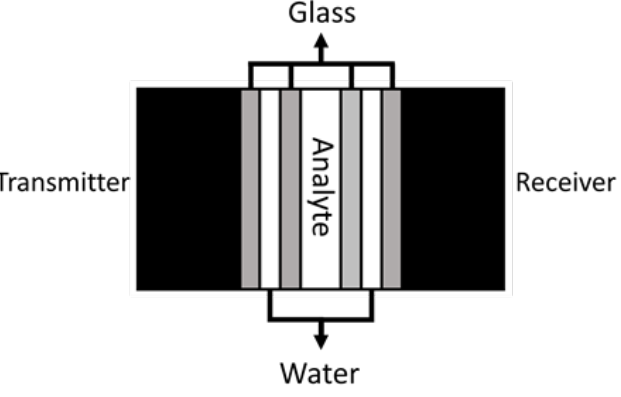
Figure 1. Phononic crystal structure representation.